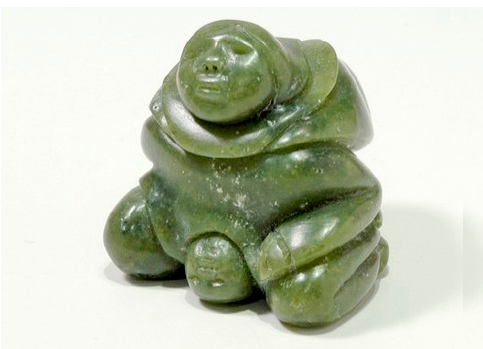
Figure 4. Birthing the Old Way , serpentine carving. Copyright 1995, Silas Kayakjuak, used with per- mission.